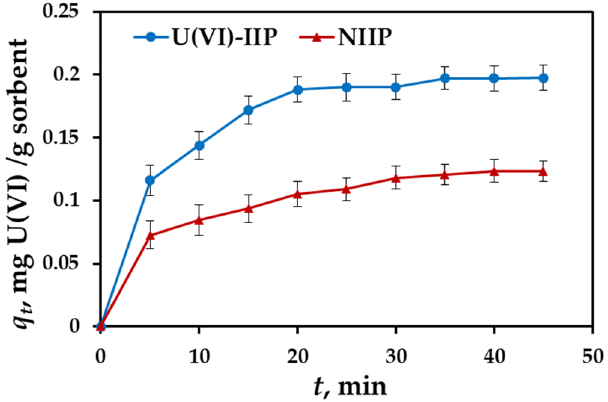
Adsorption kinetics plots of U(VI)-IIP and NIIP towards U(VI) (pH 7; sorbent dose = 100 mg/10 mL; C 0 = 2 mg U(VI)/L, temperature 298 K, three parallel experiments).